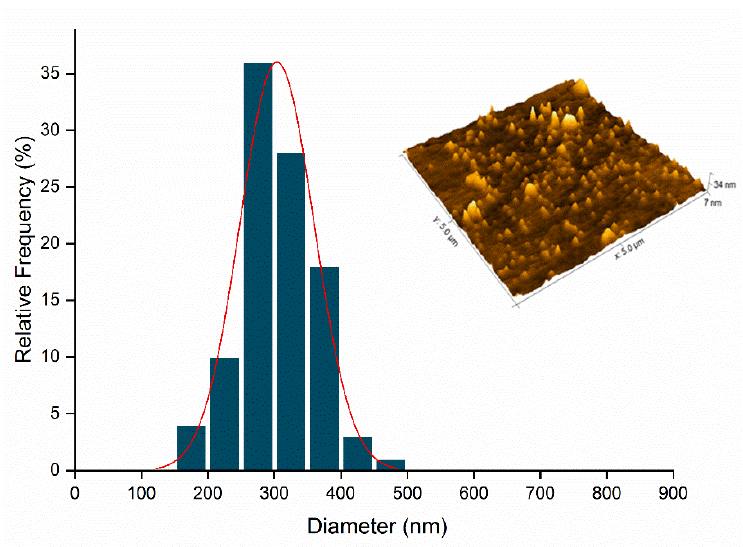
Figure 8. Representation of the size distribution graph (nm) in relation to relative frequency (%) and topography referring to the Nano_GER3% formulation.